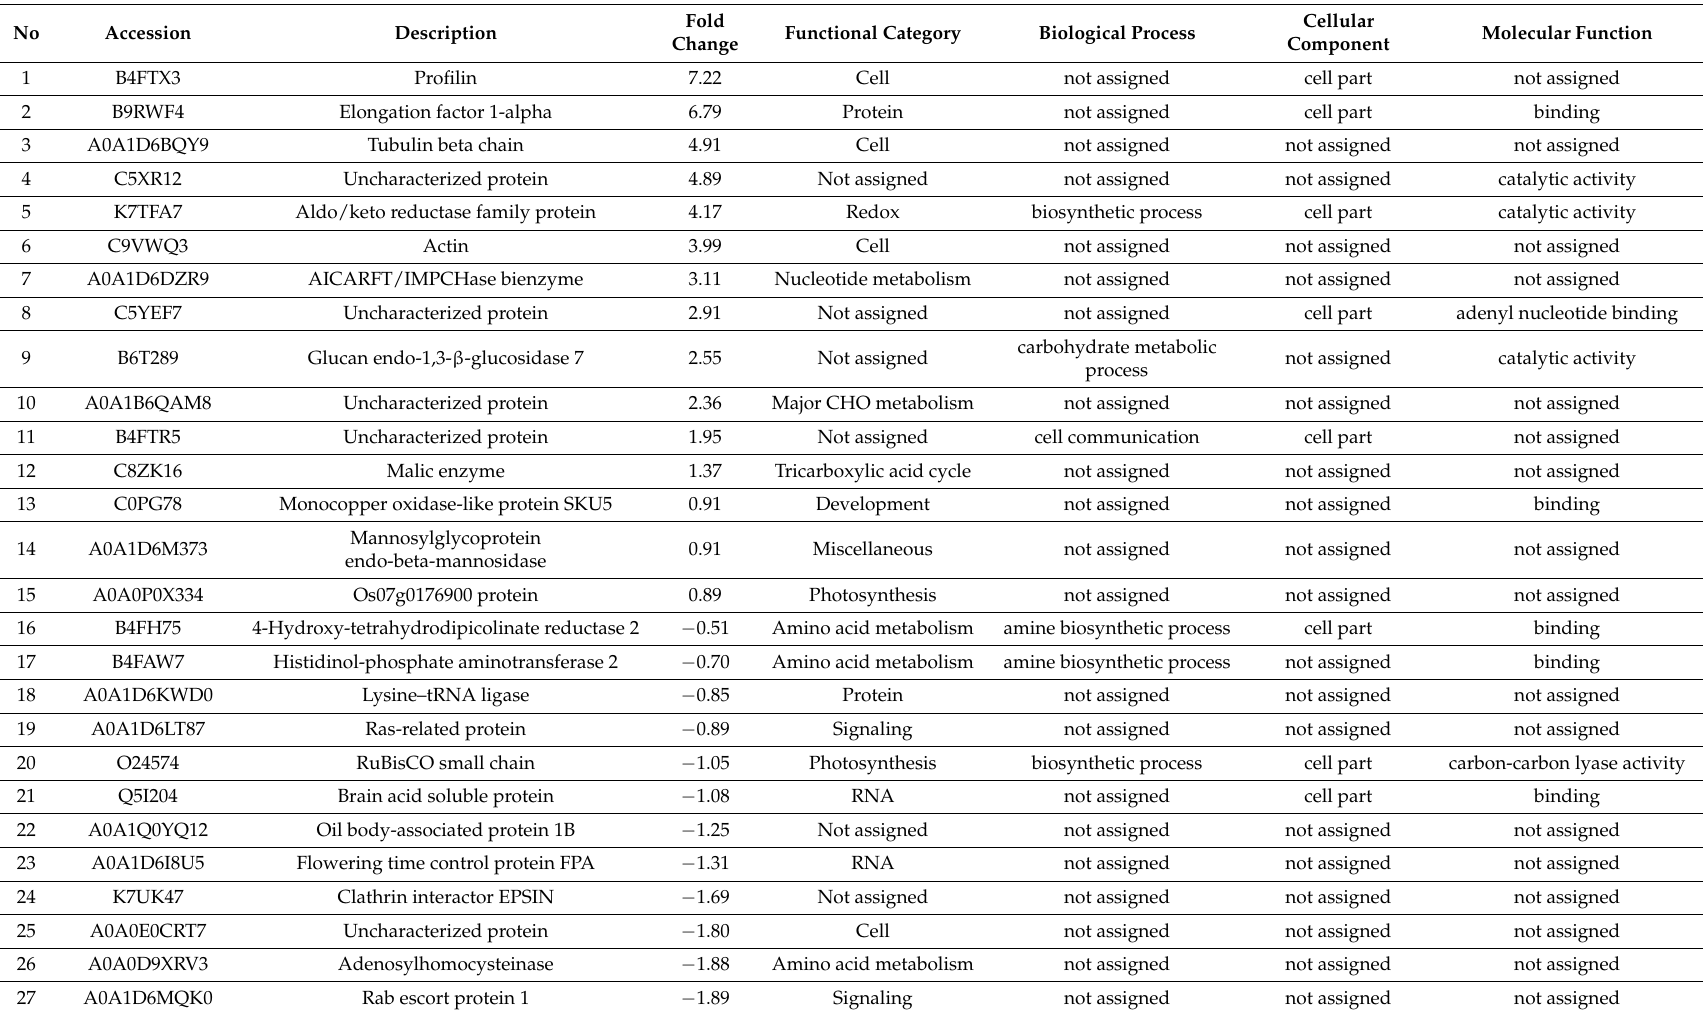
Table 1. List of proteins altered by plant-derived smoke solution in maize